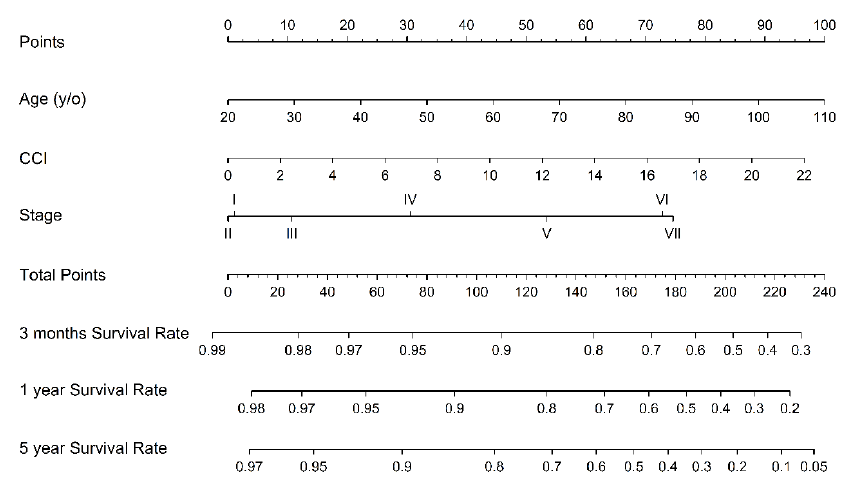
Figure 3. The nomograms of the prognostic indexes based on age, CCI (Charlson comorbidity index), and seven-stage clinical score. They give an estimate of the expected survival.